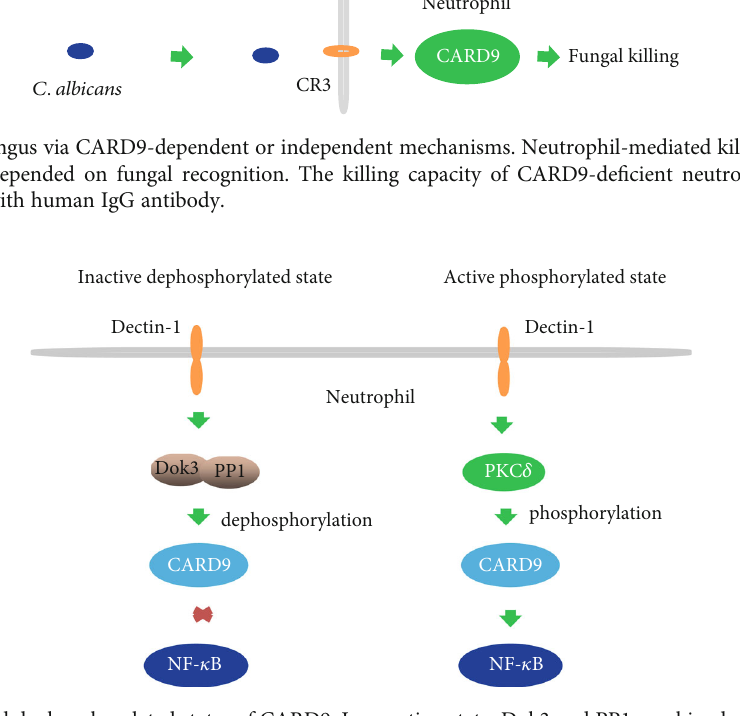
Figure 2: Phosphorylated and dephosphorylated states of CARD9. In a resting state, Dok3 and PP1 combined with CARD9 in neutrophils, maintaining the inactive dephosphorylated state of CARD9. Upon Candida infection, the Dok3-PP1 complex dissociated from CARD9, and CARD9 was subsequently phosphorylated by PKC δ